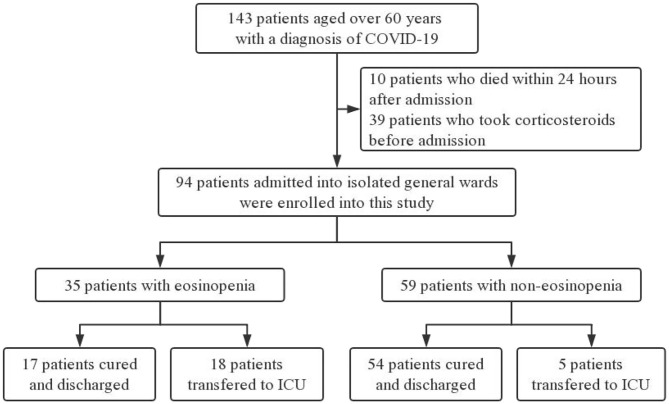
Flowchart of participants enrollment.